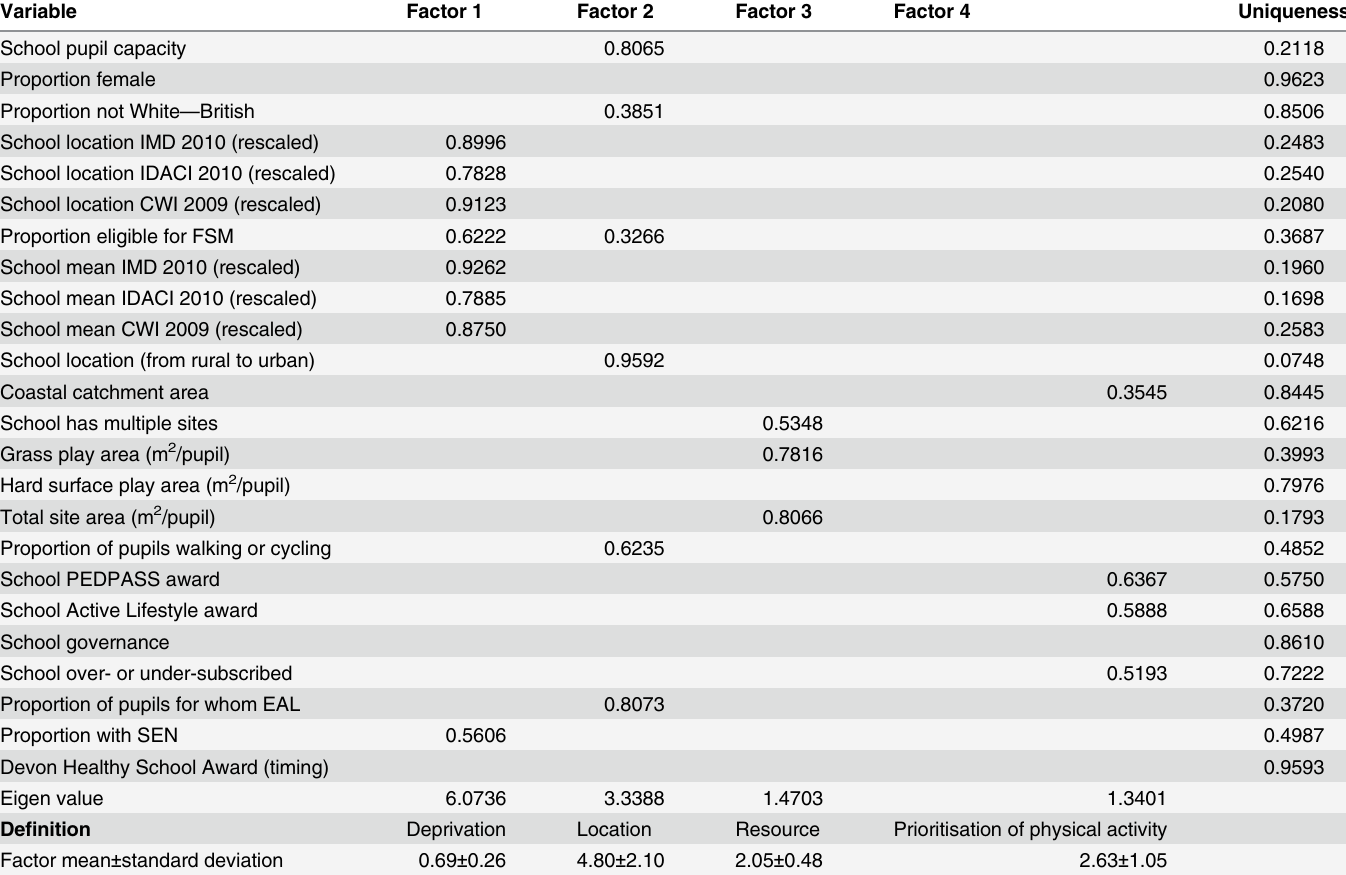
Table 3. School-based contextual factor composition and